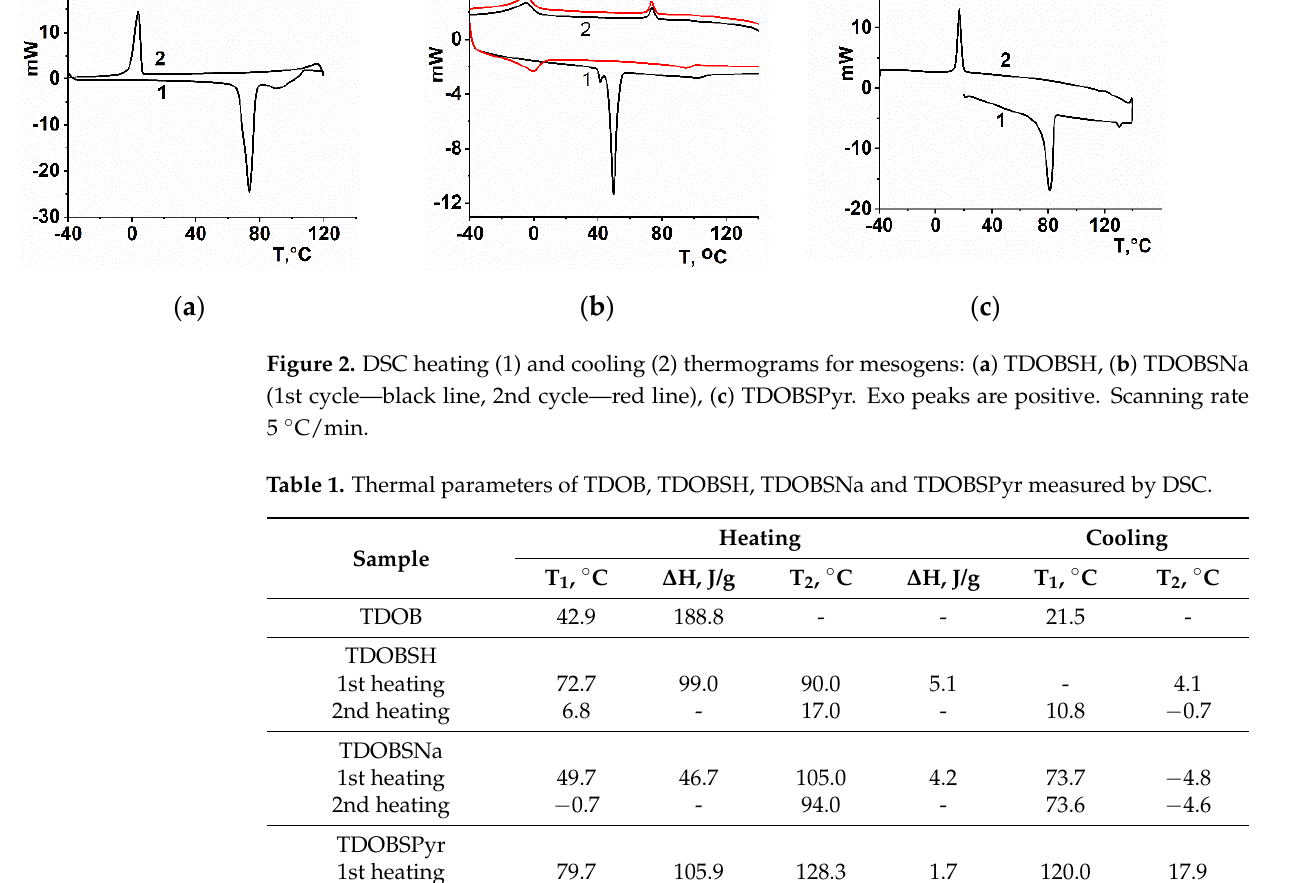
Table 1. Thermal parameter s of TDOB, TDOBSН, TDOBSNa and TDOBSPyr measured by DSC .